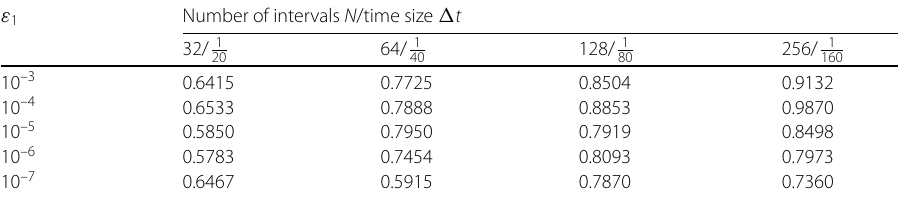
Table 9 Rate of convergence r N , M ε for Example 5.2 using the adaptive grid method with ε 2 = 10 –2 1 , ε 2